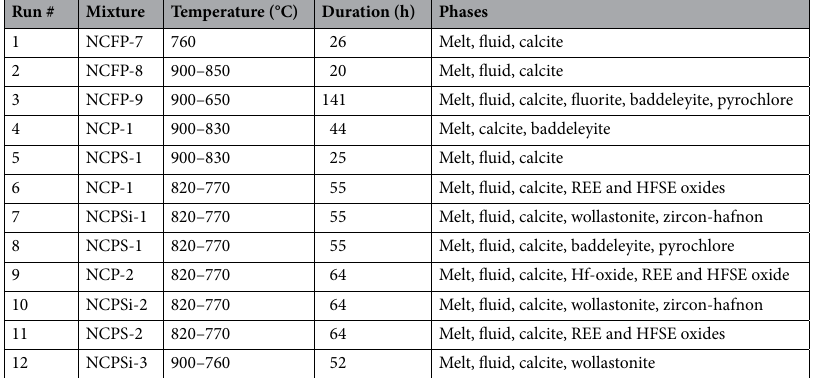
Table 2. Experimental conditions and run